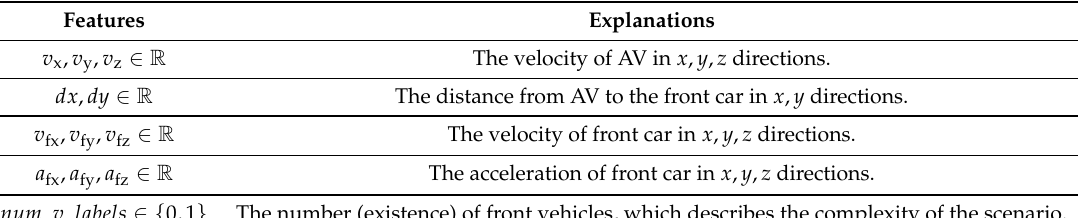
Table 1. The 12 features computed from the data of Waymo Open